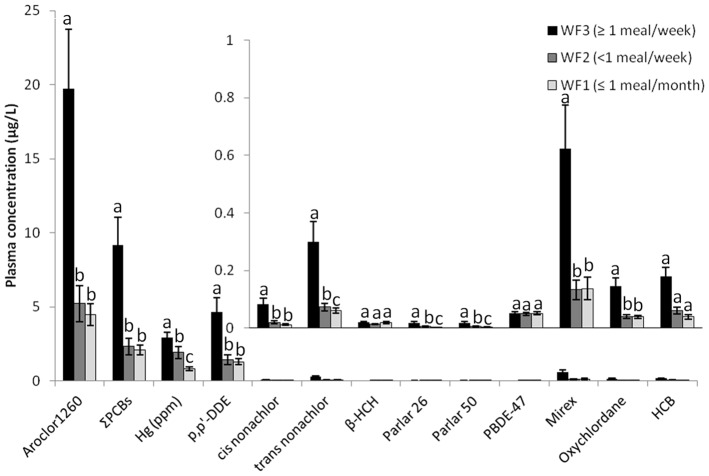
Mean (±SE) concentrations of POPs in blood (μg/L) and mercury (Hg) in hair (ppm) for participants from Wapekeka and Kasabonika First Nations consuming three levels of wild food consumption.WF1 (n = 28; ≤1 meal per month), WF2 (n = 22; <1 meal per week), and WF3 (n = 21; ≥1 meal per week). Inset is an enlargement of the concentrations for the nine contaminants on the right side of the x-axis (cis-nonachlor through HCB). Letters indicate a significant difference in groups (p<0.05) after adjustment for age. The PBDE-47 concentrations were not adjusted for age.